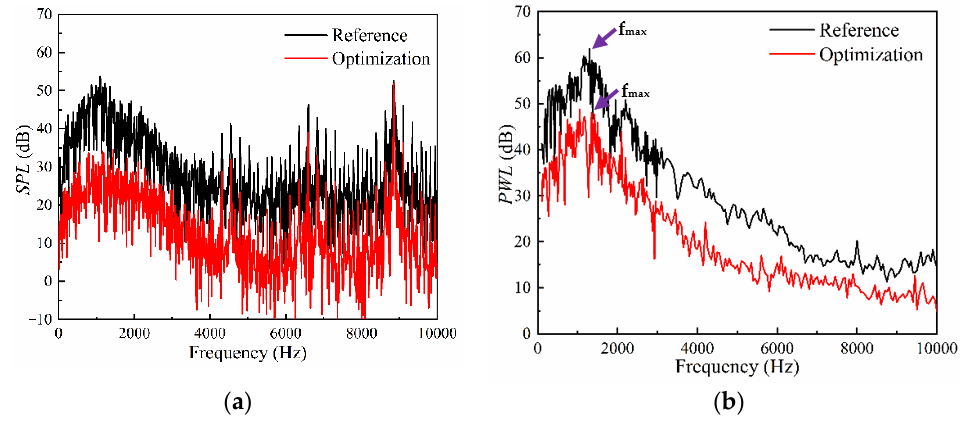
Figure 15. Comparison of the frequency spectrum. ( a ) SPL spectrum; ( b ) PWL spectrum.